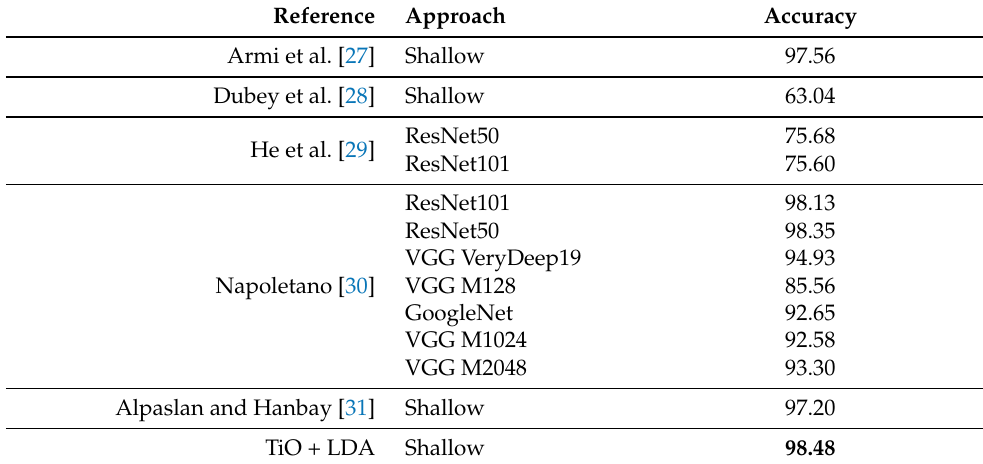
Table 4. Accuracy (%) of shallow and deep approaches on the ALOT dataset. The best result is shown in